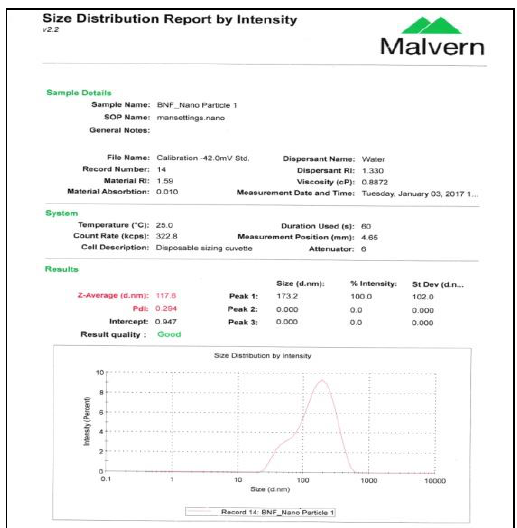
Figure A2. Size Distribution Report nano cellulose.